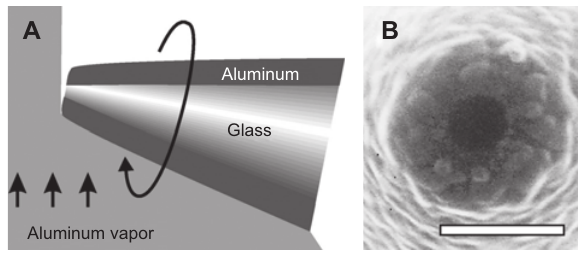
Figure 2 Aluminum-coated fi ber probe prepared by pulling and evaporation. (A) Schematics and (B) SEM image of the aperture (scale bar = 300 nm). Reprinted with permission from [16] . Copyright 2000, American Institute of Physics.